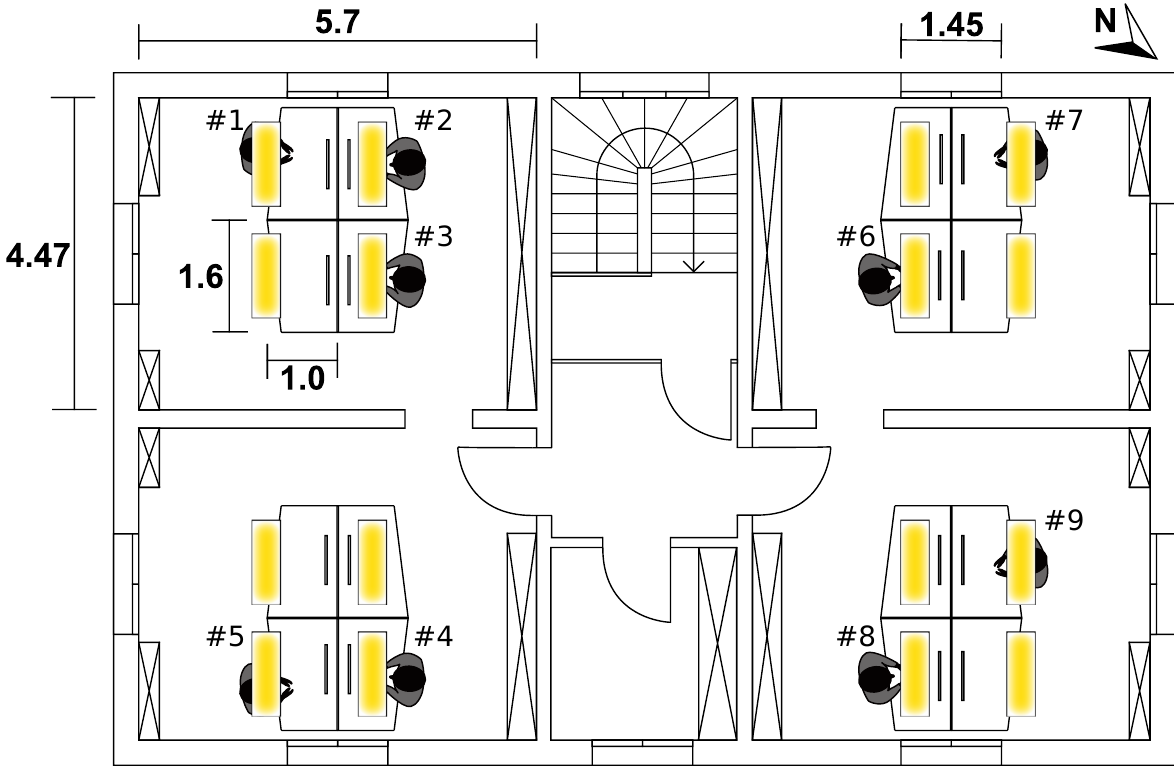
Figure 3. Room layout and luminaire positions (yellow-shaded rectangles) of the 2nd floor offices of the Laboratory of Lighting Technology at TU Darmstadt. Nine different workplaces were selected to perform the spatially resolved light measurements as proposed in this work. Workplaces #1–8 were measured on a cloudy day between 12:00 p.m. and 1:00 p.m., whereas workplace #9 was measured in the evening of the same day at 6:00